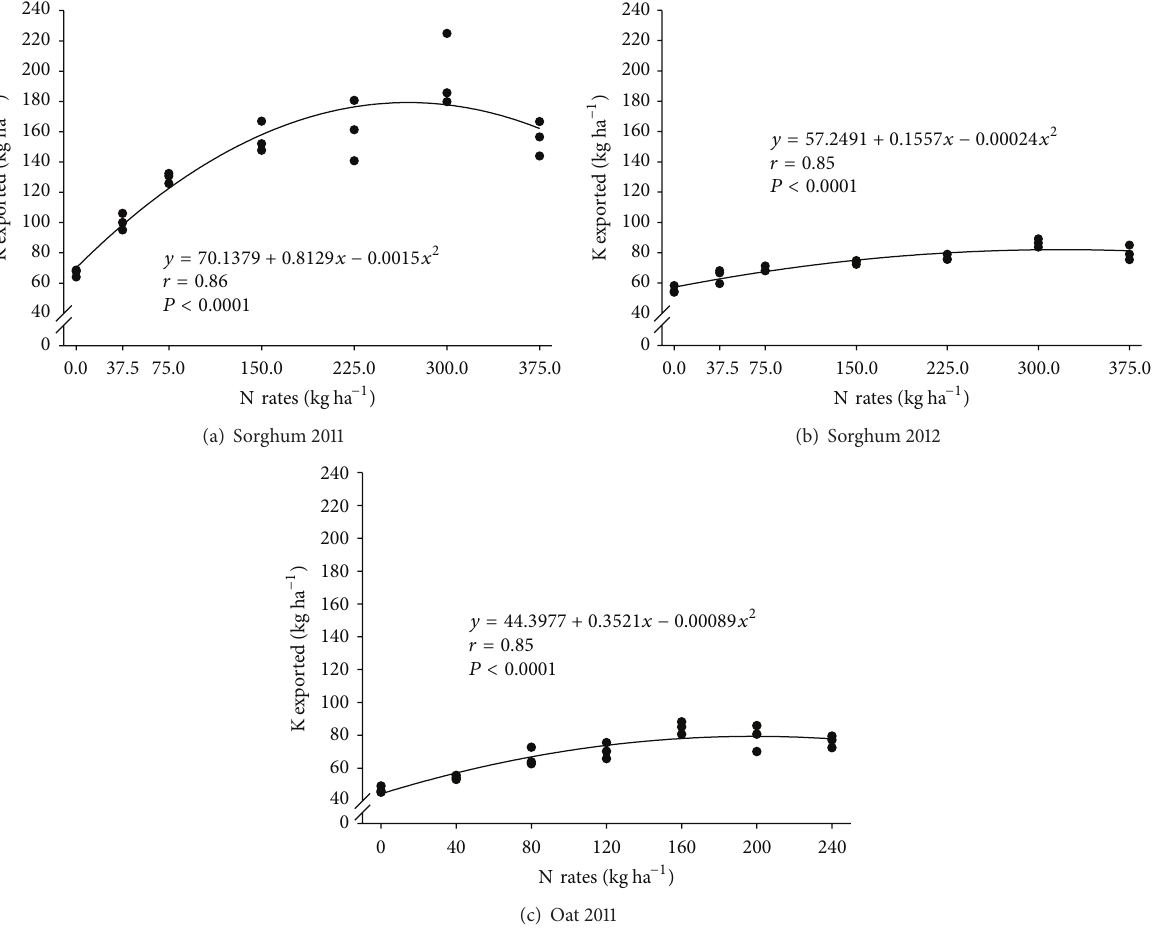
Figure 8: Potassium exported by the forage harvest of sorghum in the summer seasons of 2010/2011 (a) and 2011/2012 (b) and black oat in the winter season of 2011 (c), under nitrogen